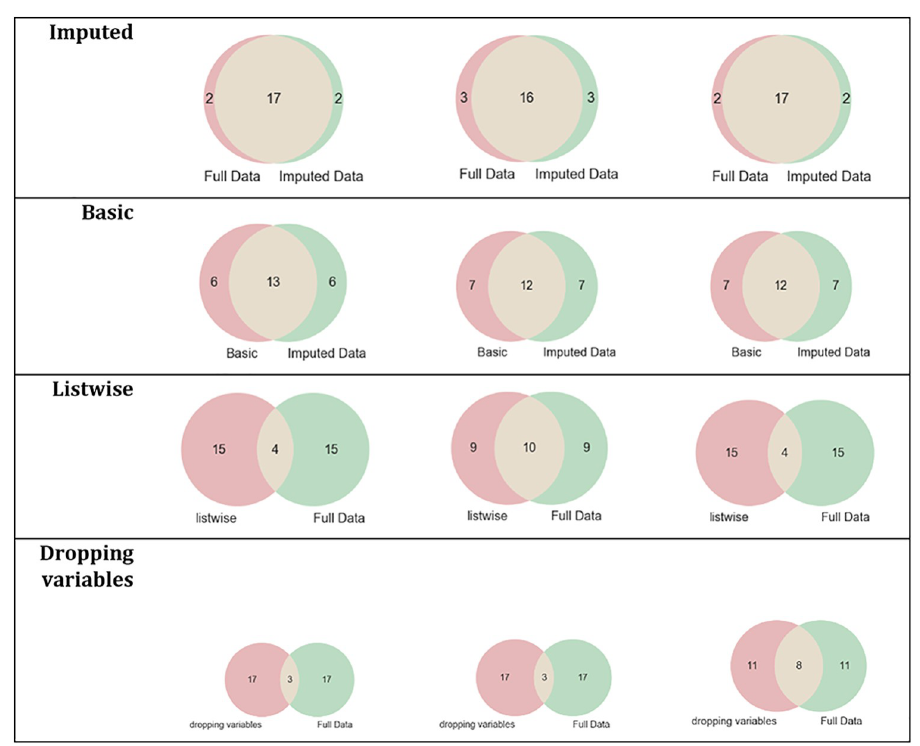
Fig 9. Intersections of sets of relevant features of the statlog dataset and its simulated datasets.